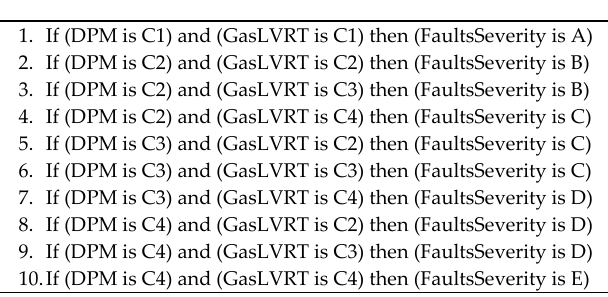
Figure 15. Rules for Faults’ Severity Fuzzy Logic.